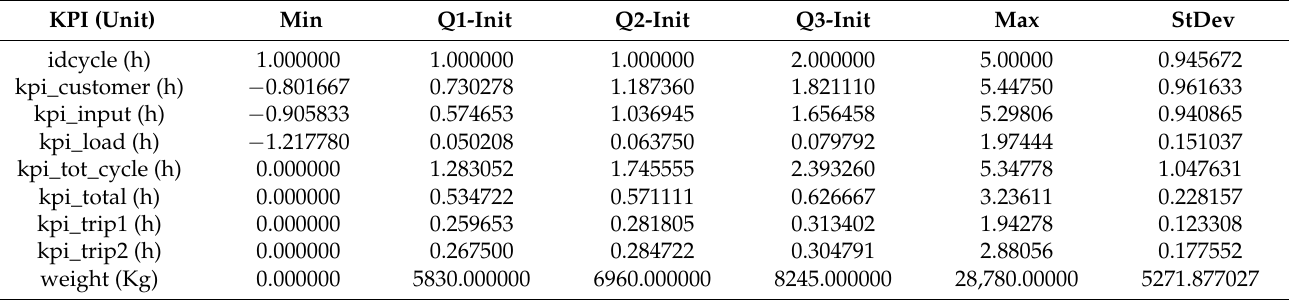
Figure 3. Correlation between KPIs in case study 1. Units for original variables were defined at Table 1. Table 2. Quartile ranges for the interesting